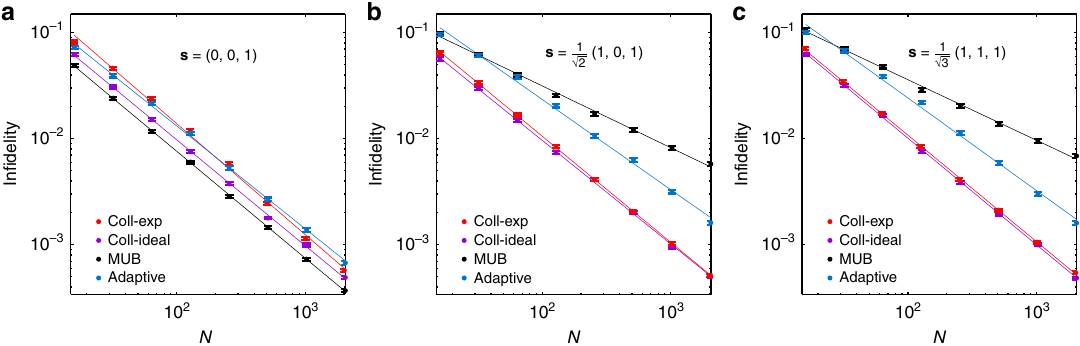
Fig. 4 Scaling of the mean in fi delity in quantum state tomography with the collective SIC-POVM. Both experimental (coll-exp) and simulation (coll-ideal) results are plotted for the collective SIC-POVM. The performances of MUB and two-step adaptive measurements (simulation) are shown for comparison. a , b and c correspond to the tomography of three pure states with Bloch vectors s as speci fi ed; N is the sample size, ranging from 16 to 2048. Each data point is the average of 1000 repetitions, and the error bar denotes the standard